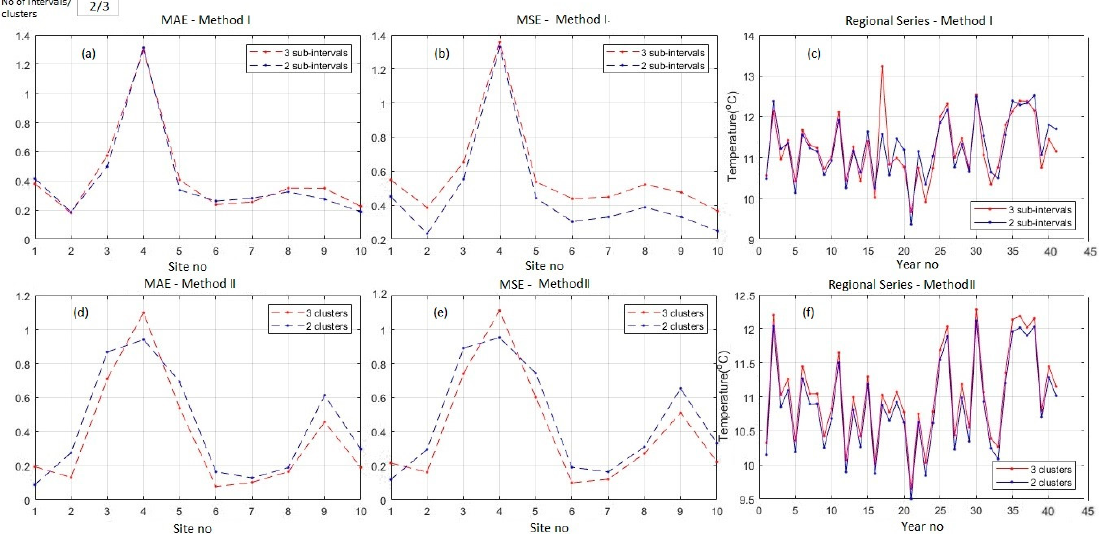
Figure 9. Comparison between the ‘Regional series’ of the average temperatures for two and three intervals/clusters: ( a ) Method I—MAE; ( b ) Method I—MSE; ( c ) Method I—‘Regional series’; ( d ) Method II—MAE; ( e ) Method II—MSE; ( f ) Method II—‘Regional series’.